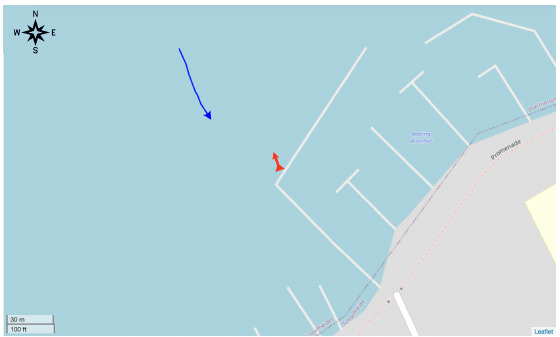
Figure 9. Geographical map of the experiment site near the Werbellin lake marina, Germany. The red arrow on the jetty represents the location and the reference (i.e., 0 ◦ ) direction of the acoustic array; the blue line and arrow represent the trajectory and movement direction of the target throughout the